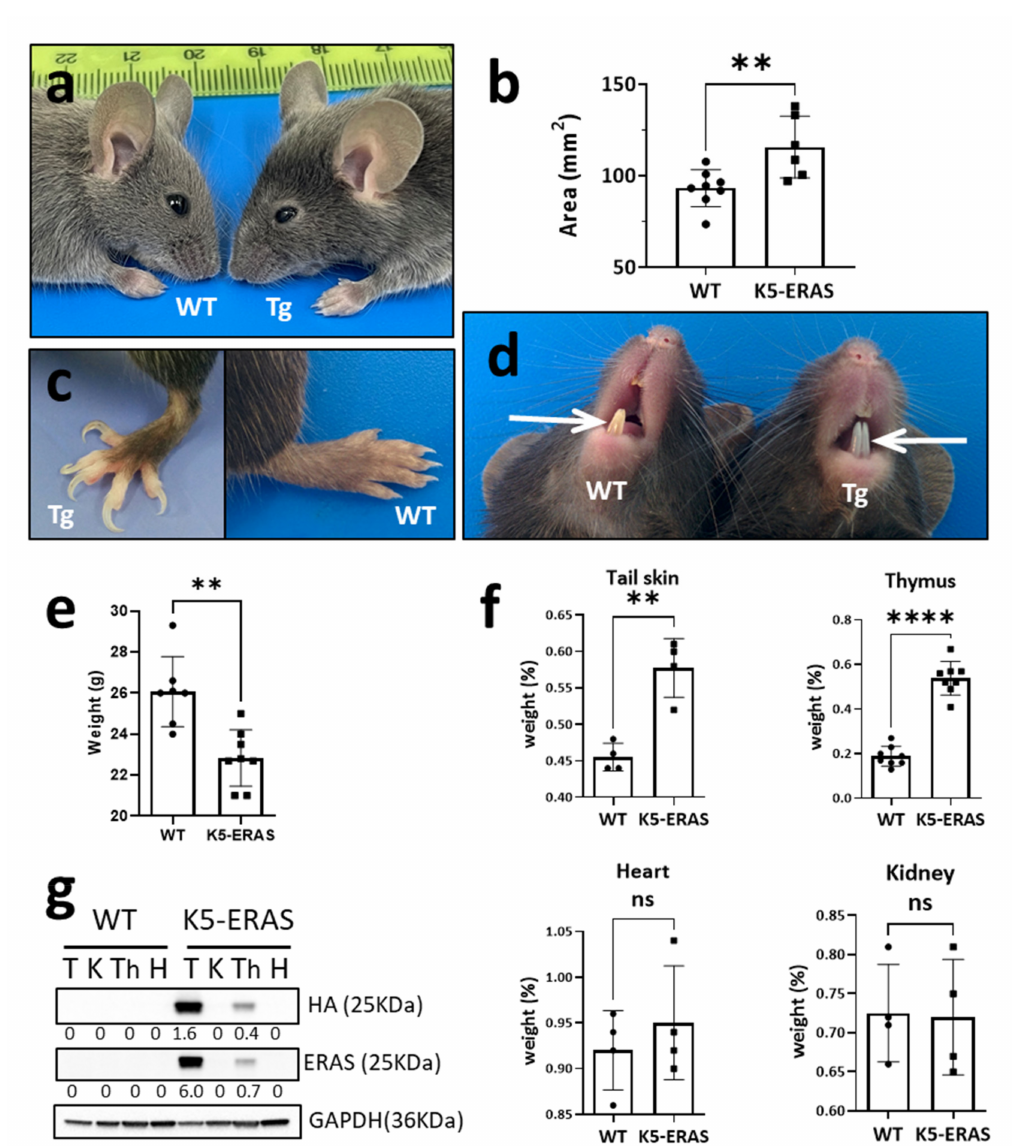
Figure 2. Gross phenotypic characterization of K5-ERAS transgenic lines. ( a ) Photograph of a K5-ERAS mouse (right) and a non-transgenic littermate (left) at the age of 40 days; note the increased ear size in the transgenic mouse. ( b ) Ear auricle area in 40-day-old mice. ** p < 0.01. ( c ) Differences in the nails of 3-month-old transgenic (left) and WT mouse (right). ( d ) Gross alterations in the color of the incisors in K5-ERAS transgenic mice. Note the whiter appearance of the upper and lower incisors (arrows) in the Tg mouse (right) compared to the WT mouse (left). ( e ) Decreased body weight of transgenic mice. The mean and S.D. of the weight of eight 60-day-old WT and Tg male mice are shown. ** p < 0.01. ( f ) Transgenic mice showed an overgrowth of organs and structures expressing the transgene (as skin and thymus), but not of organs without K5 expression, as the heart or the kidney. Graphs represent the weight of each organ as a percentage of the weight of each mouse. ns: non-significant differences; ** p < 0.01; **** p < 0.0001. ( g ) Western blot analyses of the tissues studied in ( f ), demonstrating K5-ERAS transgene expression in tail skin and in thymus, but nor in heart and kidney. T: tail skin; K: kidney; Th: thymus; H: